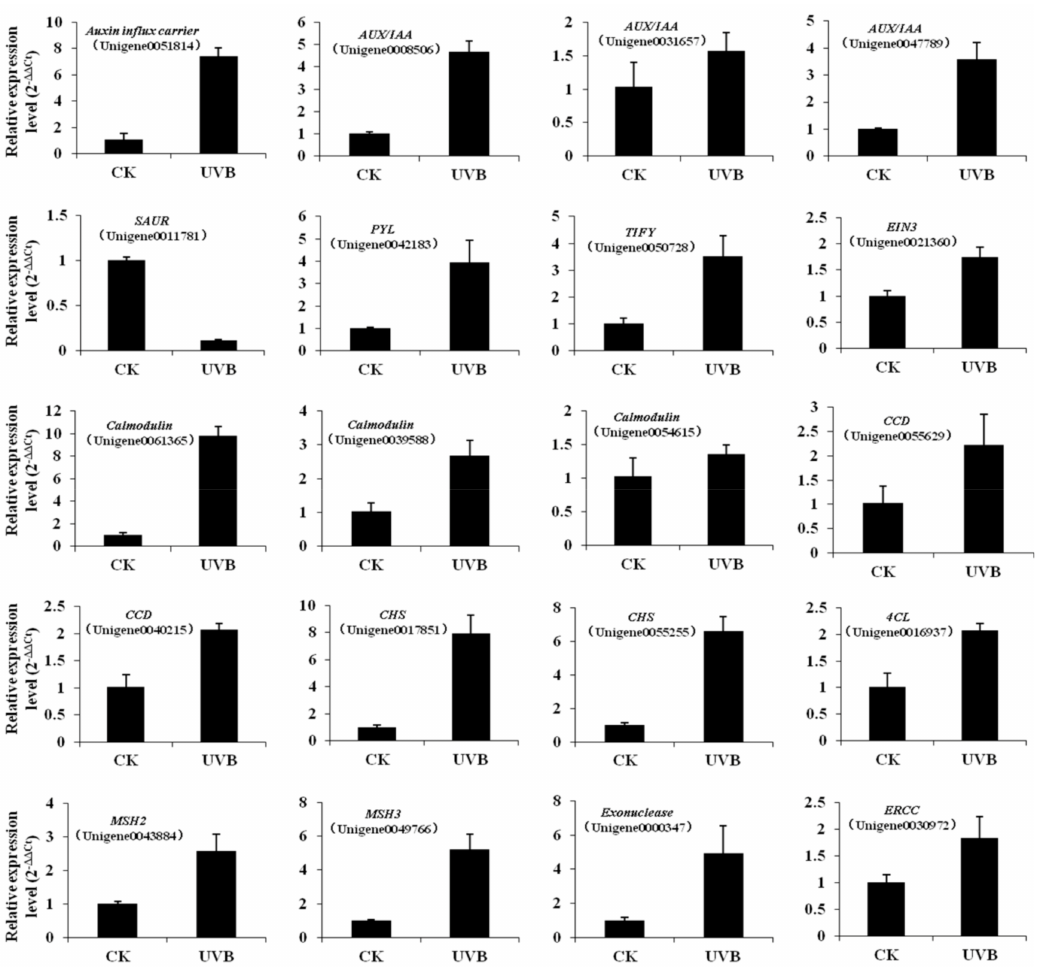
Figure 6. qRT-PCR verification of the key unigenes responding to UV-B